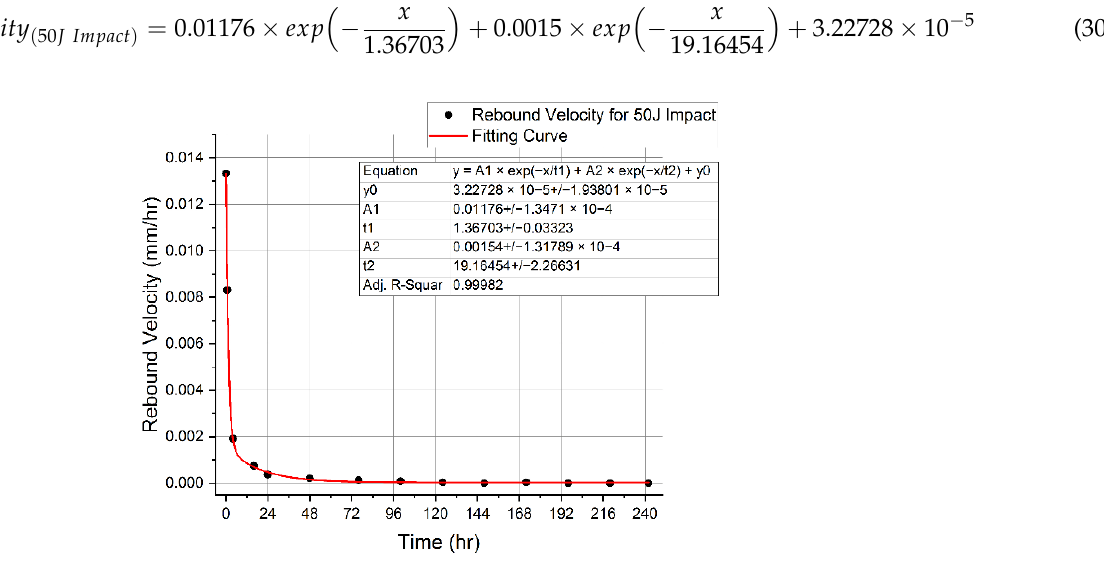
Figure 9. Fitting curve for 50 J impact case: rebound velocity vs. time graph.